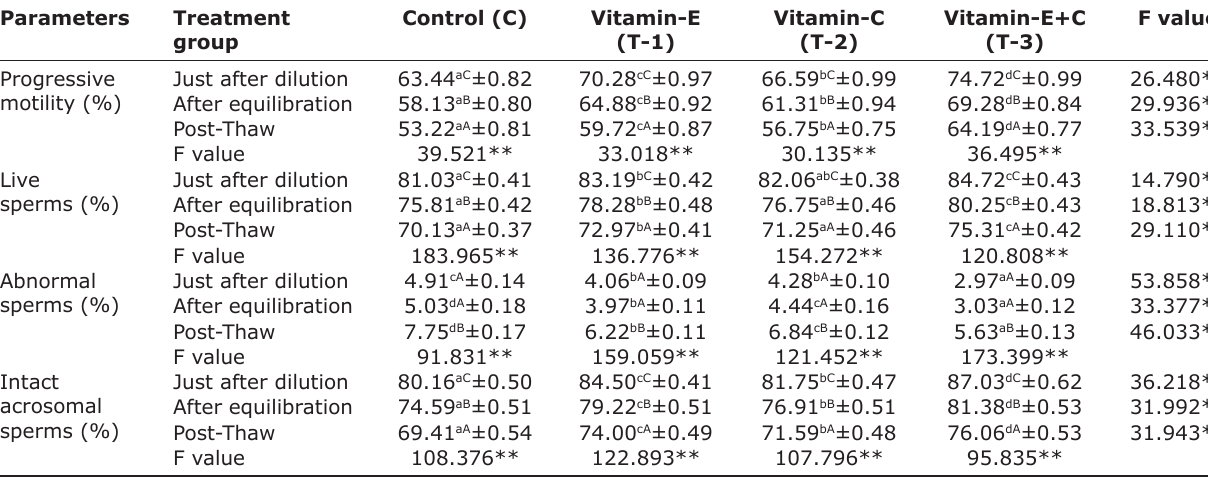
Table-1: Effect of different antioxidants and its combination on semen parameters of Bhadawari bull spermatozoa.